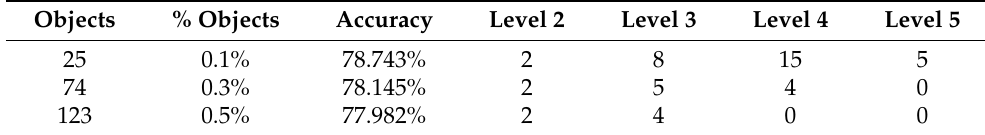
Table 4. TESSOM accuracy with variation in number of